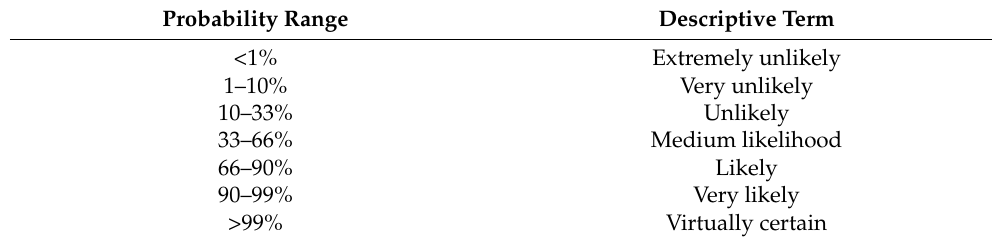
Table 8. IPCC qualitative descriptors